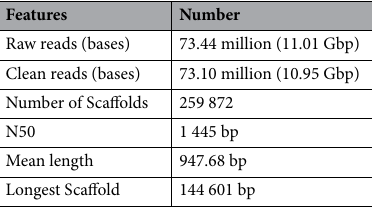
Table 1. Statistics of de novo assembly from M. casturi using Ray Assembler.